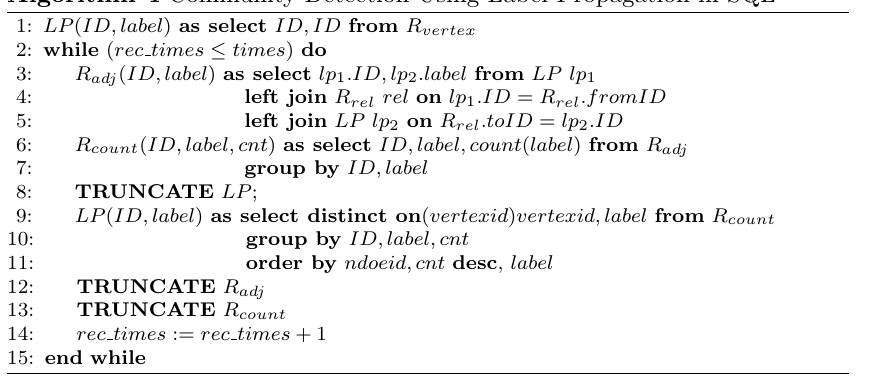
Algorithm 4 Community Detection Using Label Propagation in